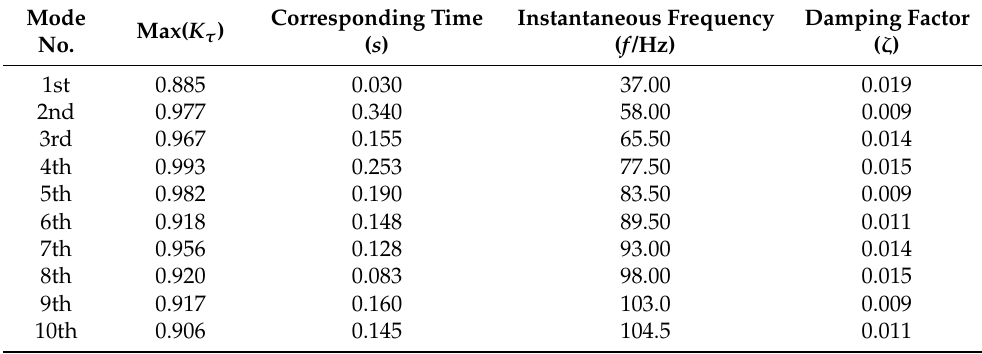
Table 7. Instantaneous frequencies and damping factors of decomposed signals of the first 20 modes of the wooden utility pole labeled as